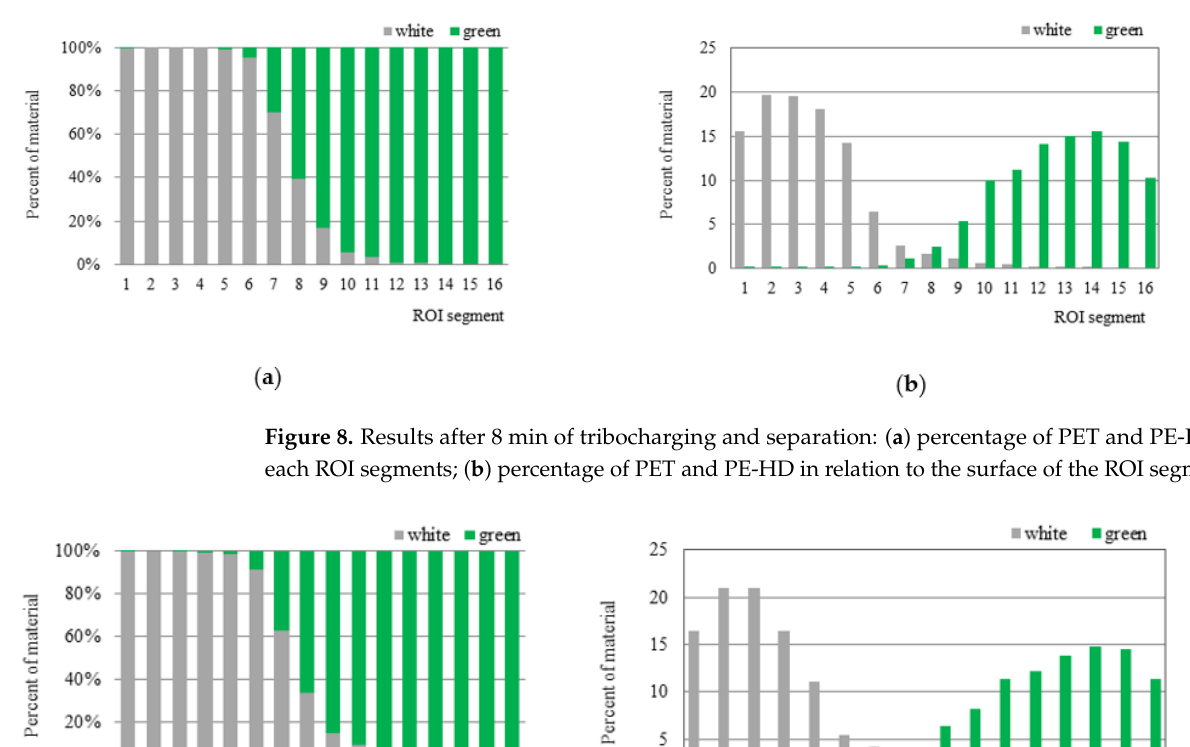
Figure 7. Charge density Q / m as a function of time t tribocharging in a PU tube for PET ( a ) and PE-HD particles ( b ) and in a cyclone for PET ( c ) and PE-HD particles ( d ).